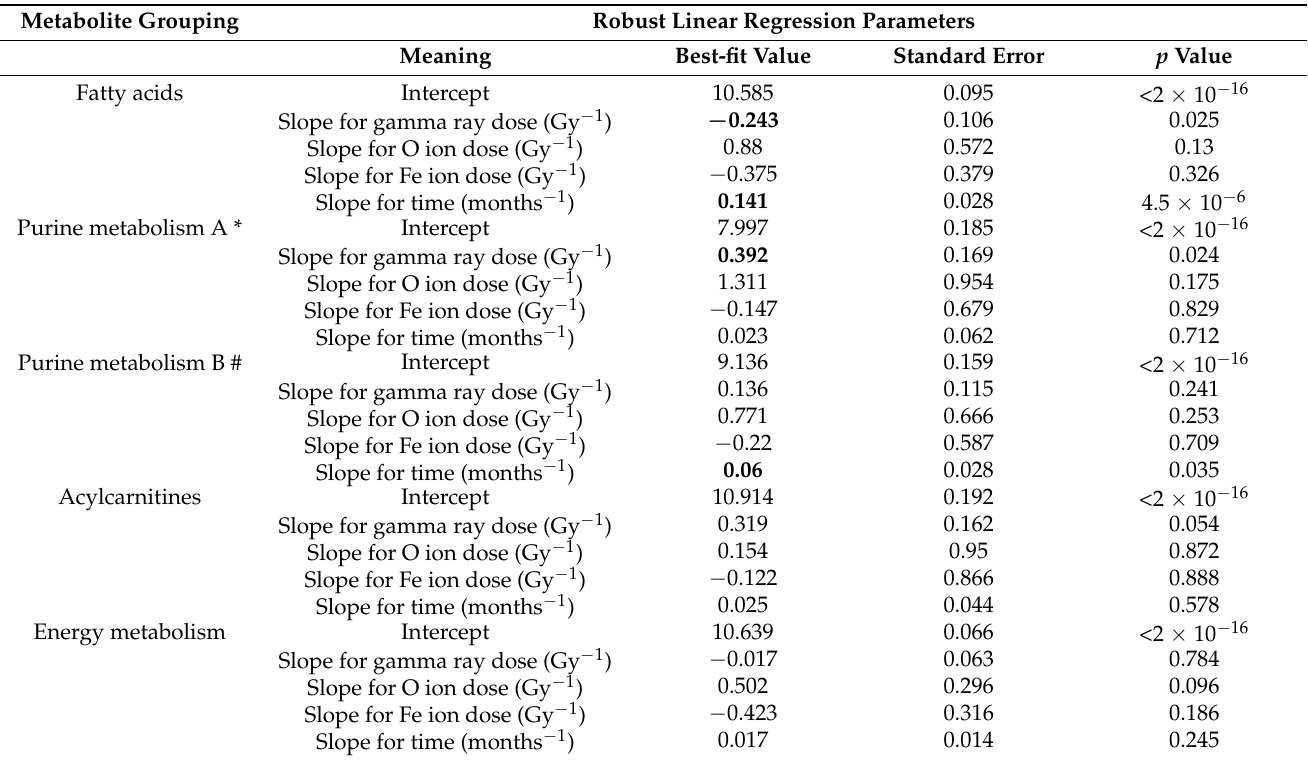
Table 2. Best-fit parameter values produced by robust linear regression for each metabolite grouping. For convenience, those parameter values for radiation or time response slopes that achieved p values < 0.05 are shown in bold font. Metabolite Grouping Robust Linear Regression